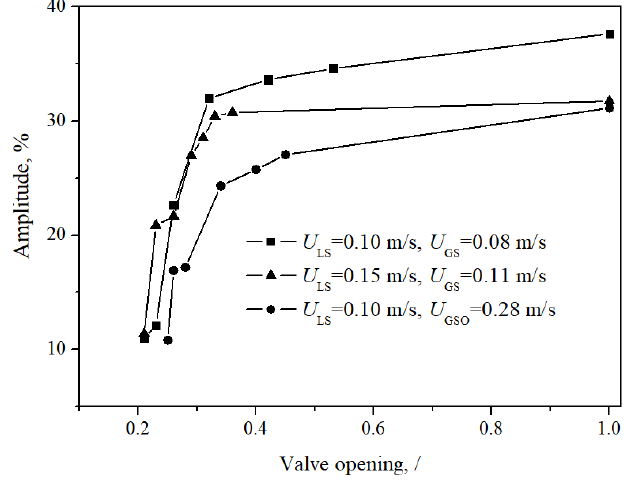
Figure 5. Amplitude of riser-base pressure oscillation against valve opening.